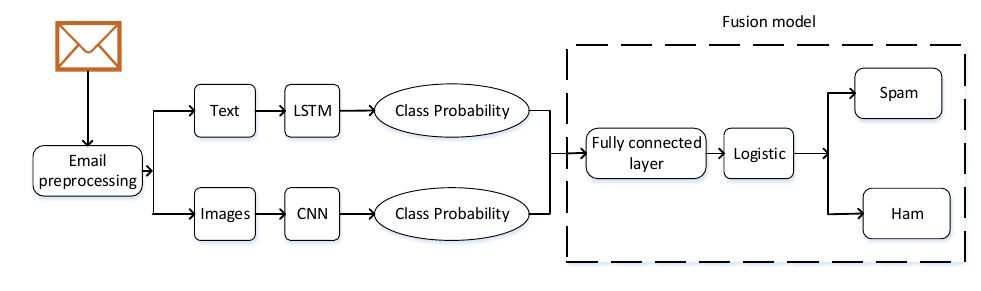
Figure 1. MMA-MF model